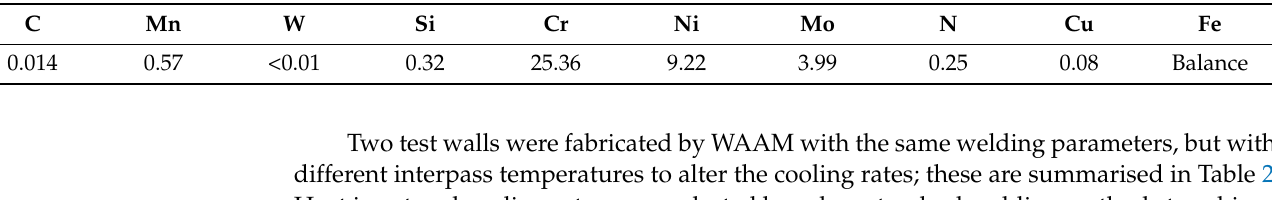
Table 1. Chemical composition of the ER2594 wire (wt.%).